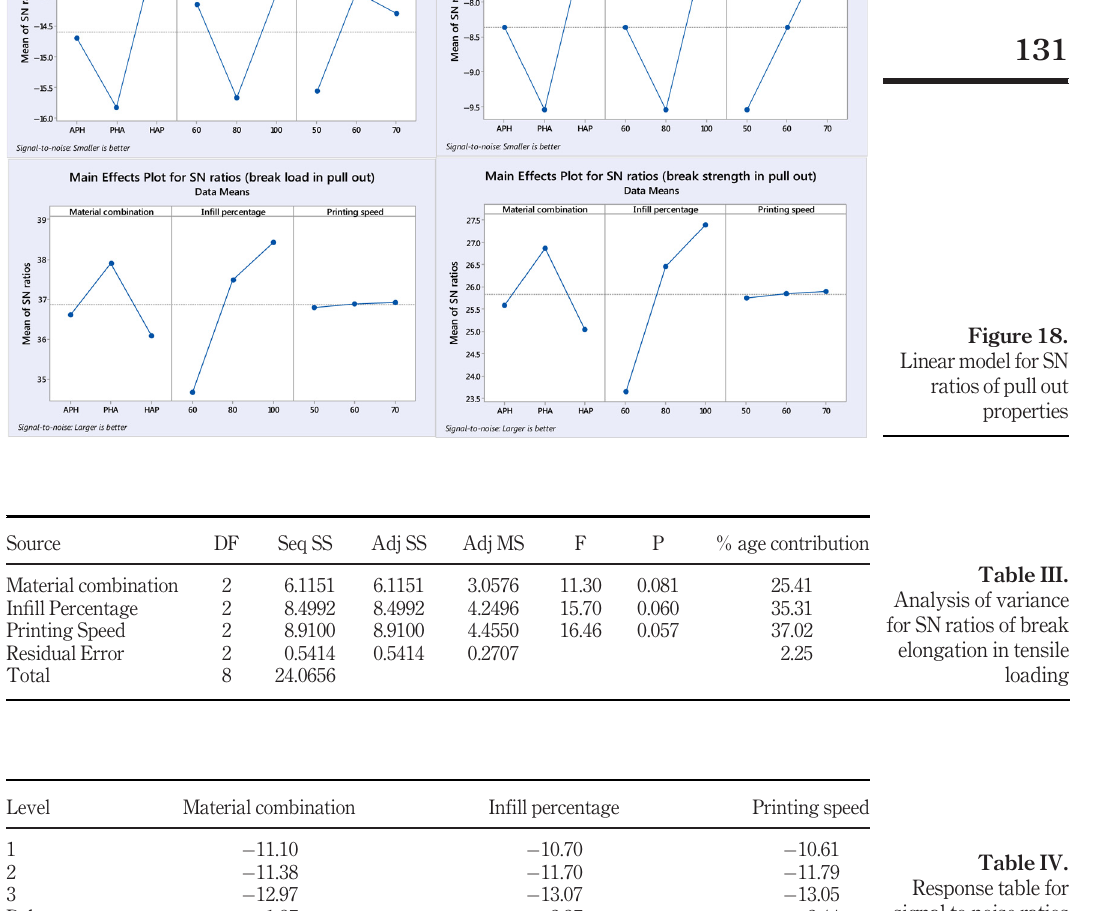
Table IV. Response table for